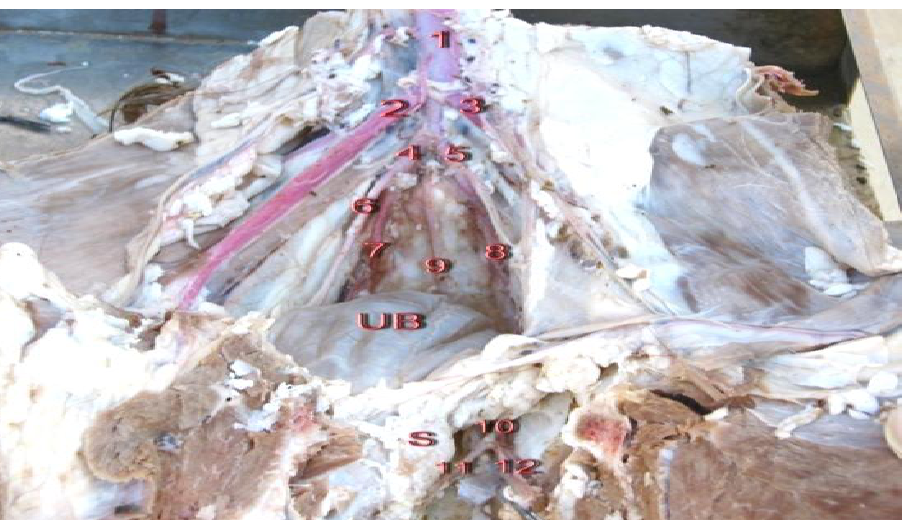
Figure 9: The blood supply of accessory sex glands seminal vesicle gland (S), urinary bladder (UB):